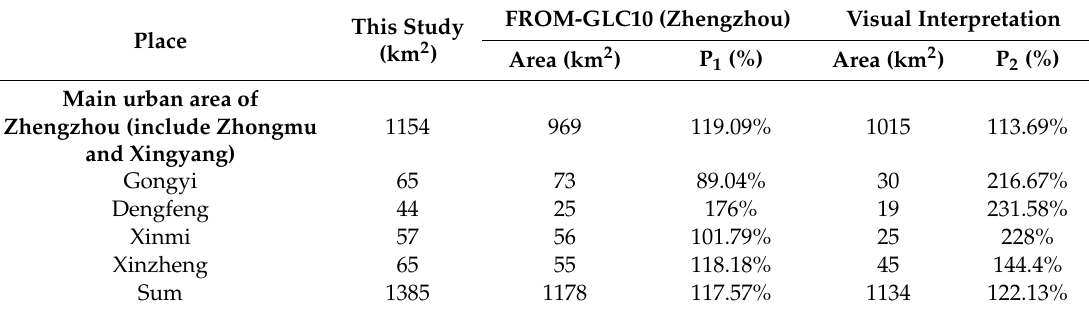
Table 4. Comparison of some products in scope over Zhengzhou.